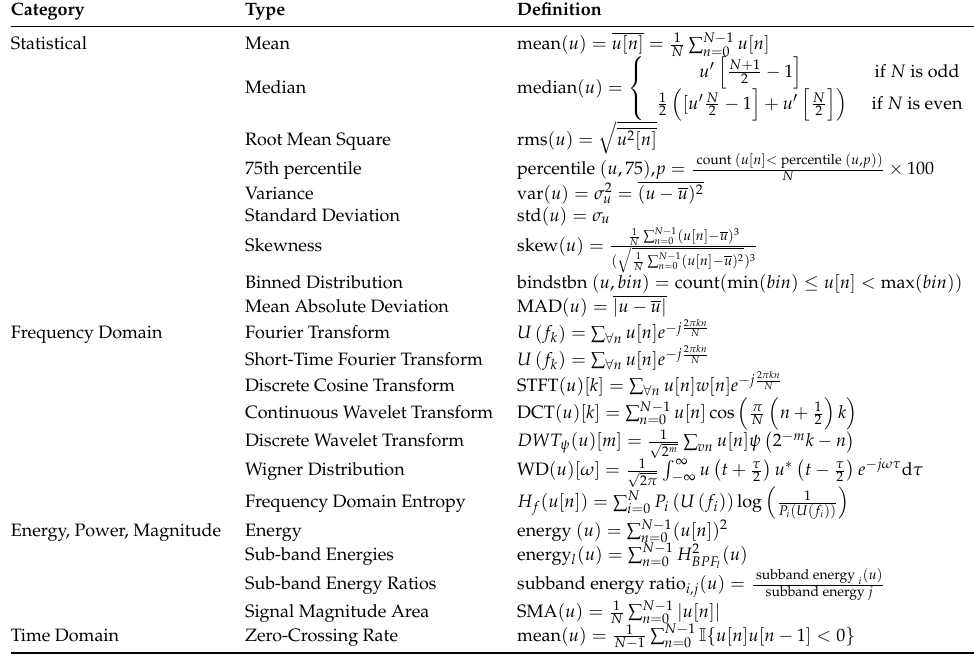
Table 1. Features extracted from